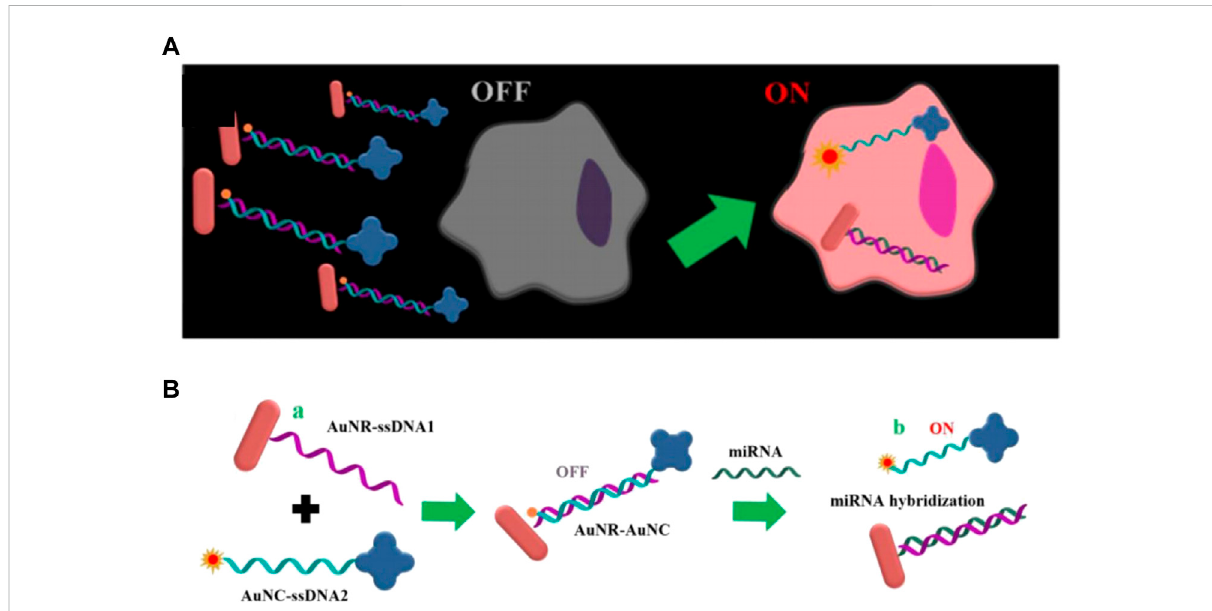
FIGURE 9 (A) Schematic illustrations of “ OFF-enhanced ON ” fl uorescent switch system for speci fi c detection of miR-21 in cancer cells. (B) Schematic illustrations of probe assembly and detection (Sun et al.,